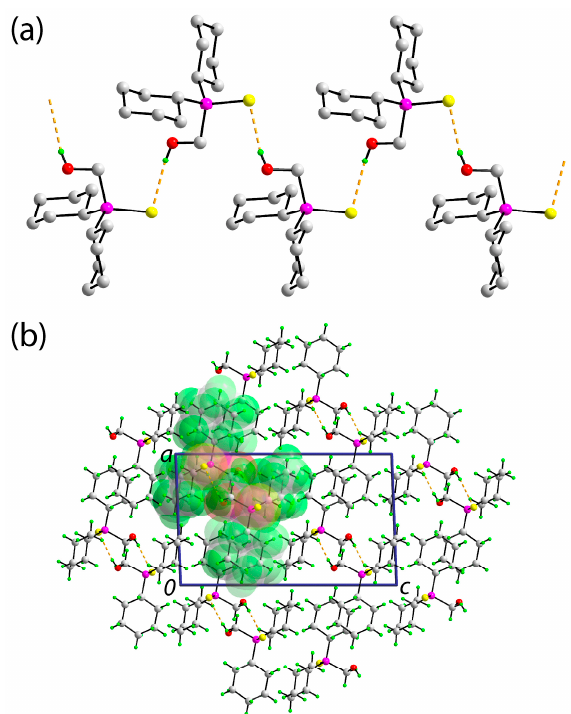
Figure 3. The molecular packing in the crystal of Compound 1 : ( a ) A view of the helical supramolecular chain along the b -axis sustained by hydroxyl-O-H ··· S(thione) hydrogen bonding [O1-H1o ··· S1 i : H1o ··· S1 i = 2.378(15) Å, O1 ··· S1 i 3.1962(10) Å, and angle at H1o = 169.4(14) ◦ for symmetry operation i: 1½- x , -½+ y , ½- z ] shown as orange dashed lines; non-participating hydrogen atoms have been omitted for reasons of clarity; ( b ) a view of the unit cell contents shown in projection down the b -axis. One supramolecular chain has been highlighted in space-filling mode.